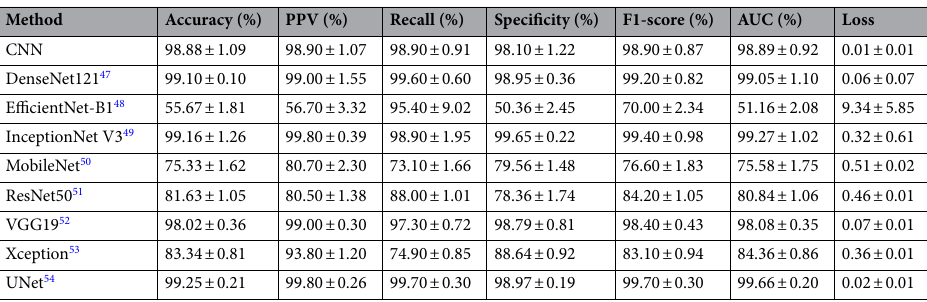
Table 8. Results of existing deep models trained on CT